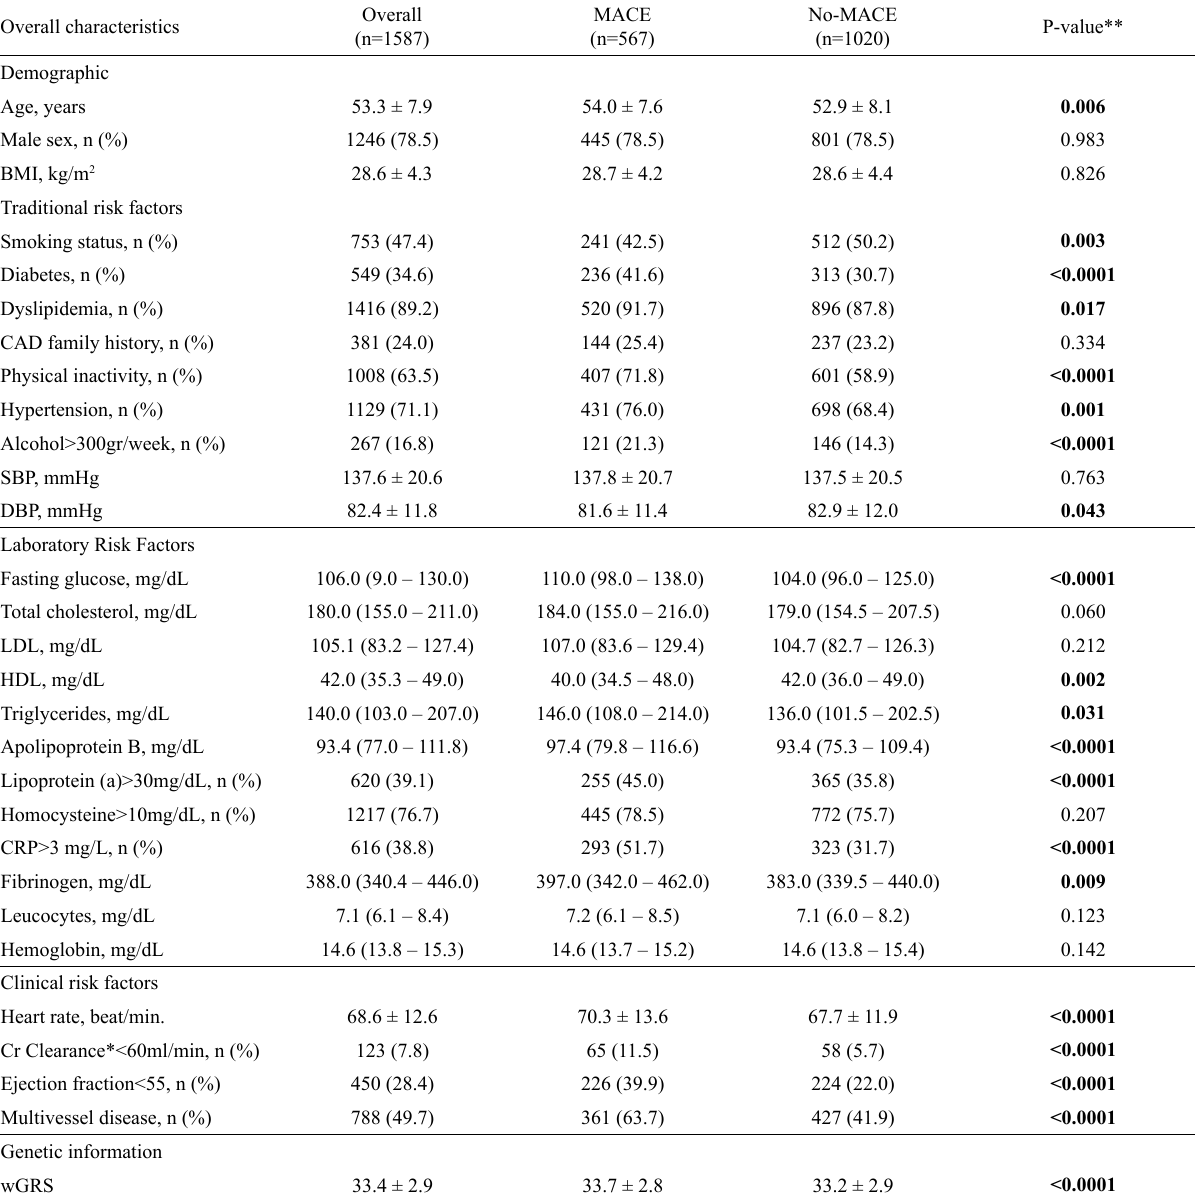
Table 1 ‒ Overall characteristics of the study